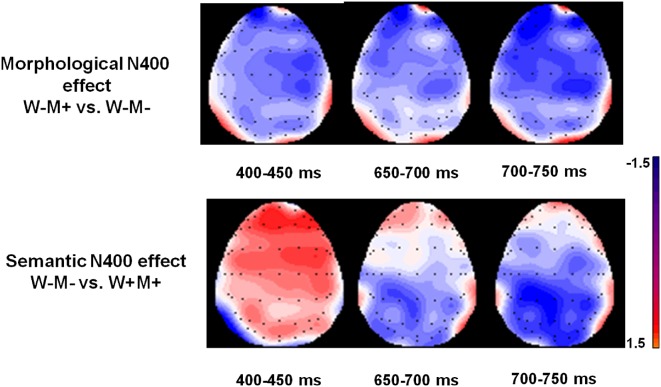
The voltage maps of the morphological N400 effect and semantic N400 effect. The topographic map of morphological N400 effect is based on the differences in waves between the W−M+ and W−M− conditions. The topographic map of the semantic N400 effect is based on the differences in waves between the W−M− and W+M+ conditions.